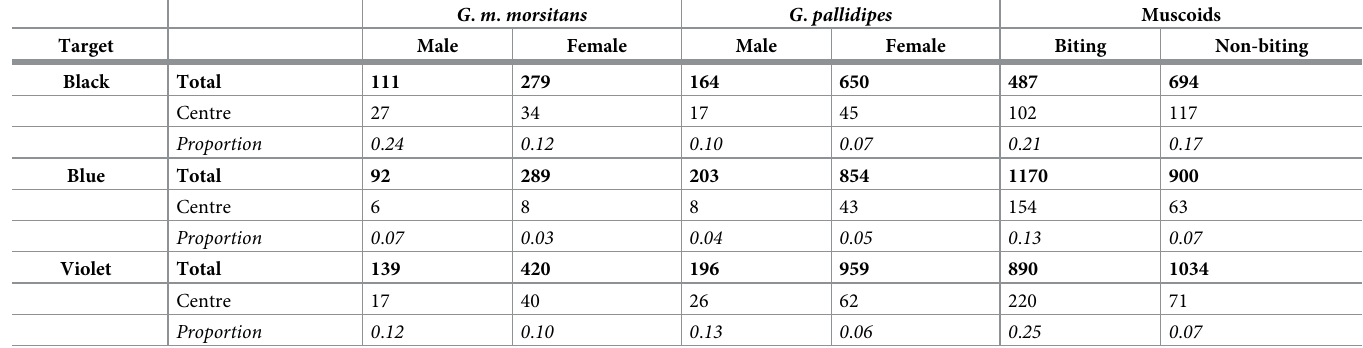
the typical blue polyester and black cotton targets. Again, the mean catch of females at the vio-